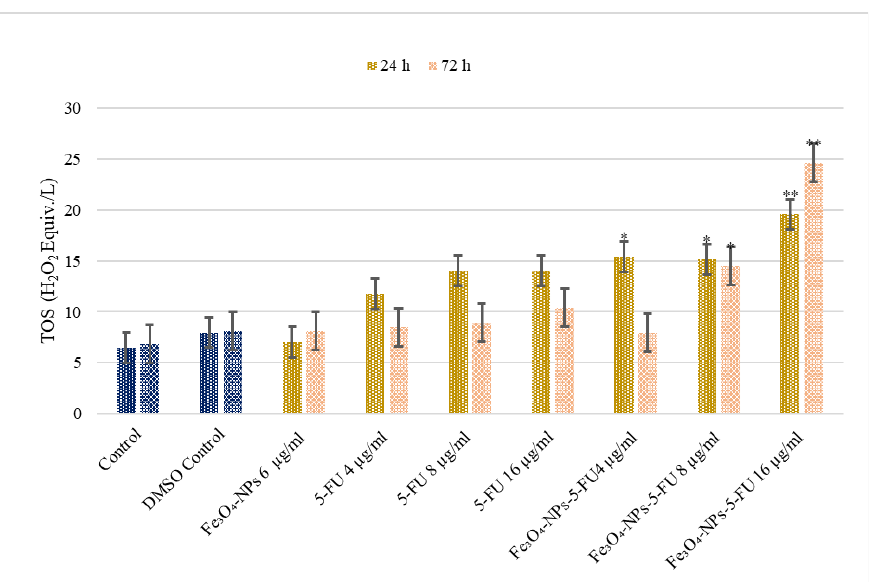
Figure 6. The effect of Fe 3 O 4 0-NPs, 5-FU, and Fe 3 O 4 -NPs + 5-FU on Caco-2 cells TOS levels (n = 6). Cells were cultured in 96-well plates and treated with Fe 3 O 4 _NPs 6 µ g/mL, 5-FU (4, 8, and 16 µ g/mL), and combinations of Fe 3 O 4 + 5-FU NPs for 24 h and 72 h, and TOS determined. The results represent the average of three separate experiments. Statistical significance: * p < 0.05; ** p < 0.01.